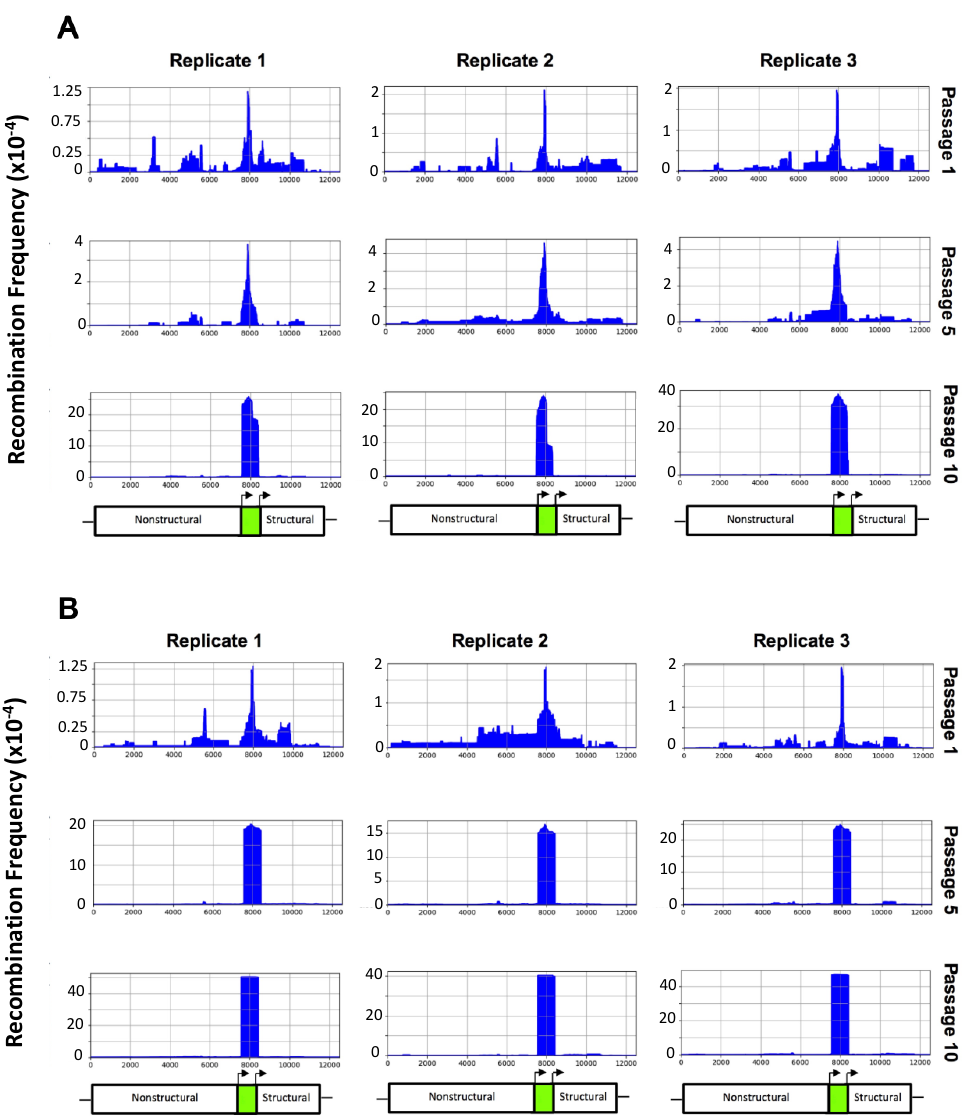
Figure 2. ViReMa recombination results for TC-83 GFP and low-fidelity TC-83 GFP. Passages 1, 5, and 10 are shown for each TC-83 GFP ( A ) and low-fidelity TC-83 GFP ( B ) replicate. The x -axis shows genome position, while the y -axis shows the recombination frequency (i.e., normalized to the total reads that map to TC-83 GFP). Below the recombination charts, a schematic shows the approximate location of the nonstructural protein, GFP, and structural